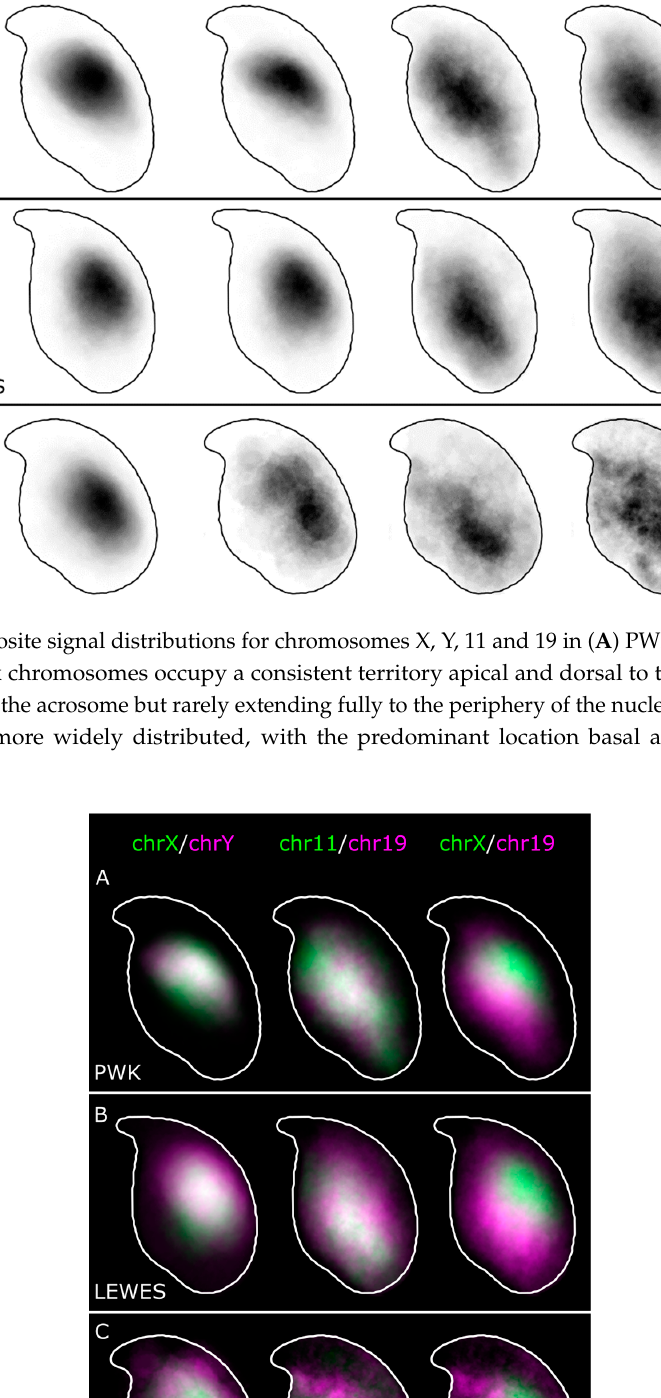
Figure 4. Overlay of warped distributions from Figure 3 shows the similarities between chromosome X and Y territories, and 11 and 19 territories in ( A ) PWK ; ( B ) LEWES ; and ( C ) STF . White shows regions of overlap. Chromosomes X and 19 (and X and 11) are predominantly non ‐ overlapping.